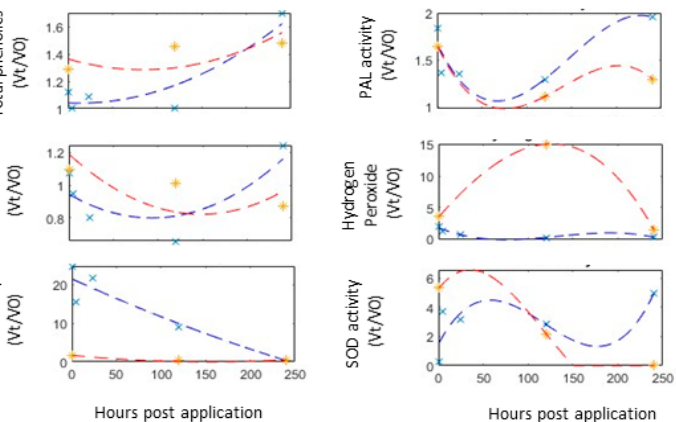
Figure 4. Mathematical modeling of plant immune responses to non-self eDNA ( Fusarium eDNA at 150 ppm) applied in adult plants. Data showed in normalized dimensionless values for each sampling time in hours post treatment application. Blue lines represent responses to first application and red lines represent responses to second application of treatment.